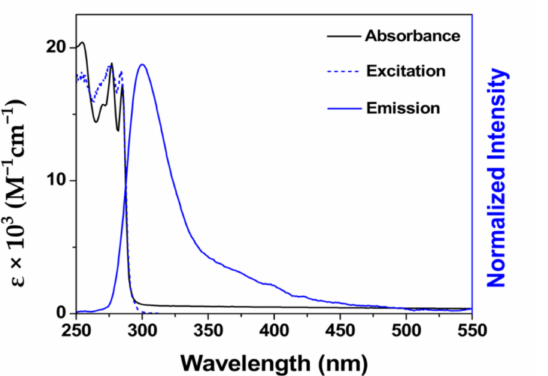
Figure 1. UV–Vis absorption, excitation, and emission spectra of 1.0 × 10 − 4 M BimOEt 3 in ethanol at 298